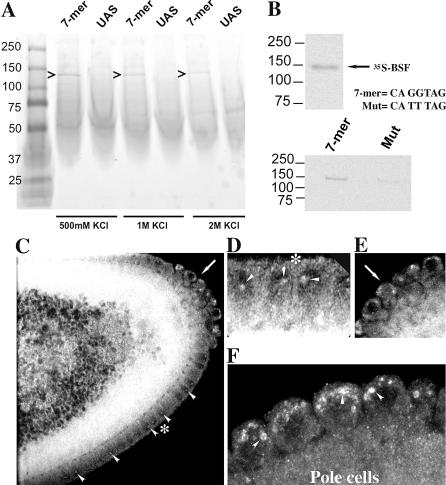
Purification of BSF as the 7mer Interacting Protein(A) Coomassie staining of 7mer interacting protein. Forty grams of embryo extract was prepared as described in Materials and Methods, and subjected to two sequential purification steps. In the first step, proteins were loaded onto an agarose column coupled to the UAS. Unbound proteins were then split into two equal fractions, and each fraction was loaded onto the 7mer or UAS columns. Bound proteins were eluted with a step concentration of KCl and resolved on SDS-Page. Gel shows the results of this last purification step. One major interacting protein bound specifically to the 7mer oligo. Mass spectroscopy sequencing identified this protein as the BSF.(B) BSF binds directly and specifically to the 7mer. BSF was in vitro transcribed and translated in the presence of 35S-methionine (35S-BSF; upper panel), and the binding to the 7mer or to a mutated sequence (MUT; the two GG at position 3 and 4 were mutated to TT) was tested (lower panel).(C–E) Confocal microscopy analysis of BSF localization in the early embryo. A BSF polyclonal antibody was used to detect the endogenous localization of BSF. BSF was localized to both the cytoplasm and nuclei (arrowheads in [C] and [D]) of the blastoderm epithelium. In pole cells, BSF was localized to cytoplasmic structures, which appeared as dots, arrowhead (F). The arrow in (C) indicates the region which is enlarged in (E). The asterisk (*) in (C) indicate the region which is enlarged in (D).